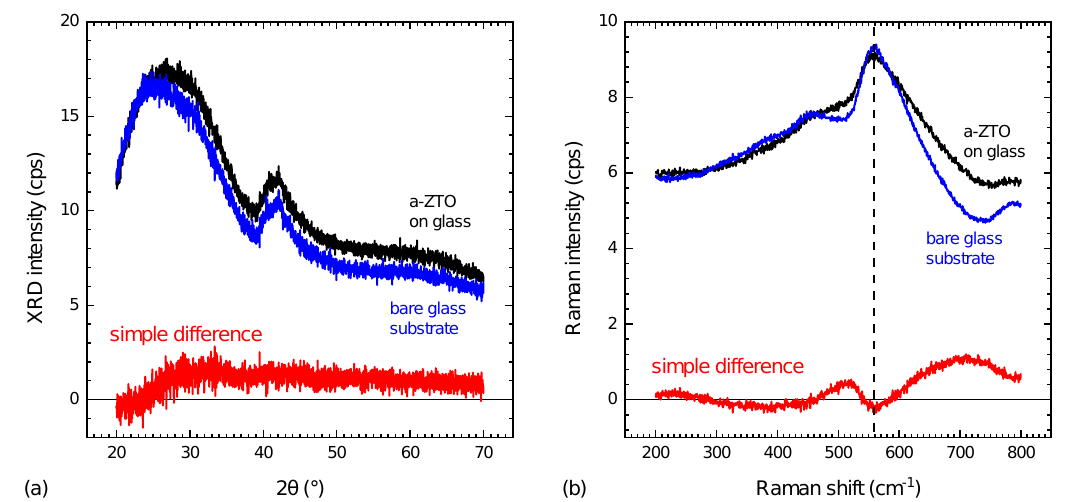
Figure 1. Example of the failings of diffraction-based techniques and simple background subtraction method for Raman spectra of a thin amorphous transparent conducting oxides (TCOs) on glass. ( a ) X-ray diffraction (Bruker D8 Advance, unmonochromised Cu K α in parallel beam